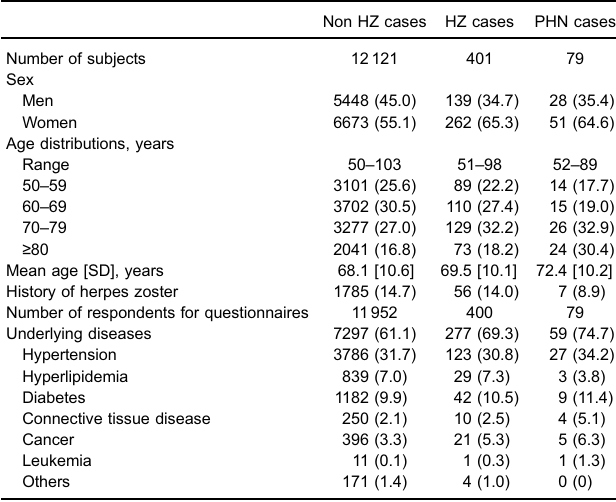
Table 2. Baseline characteristics in non-herpes zoster cases, herpes zoster cases, and